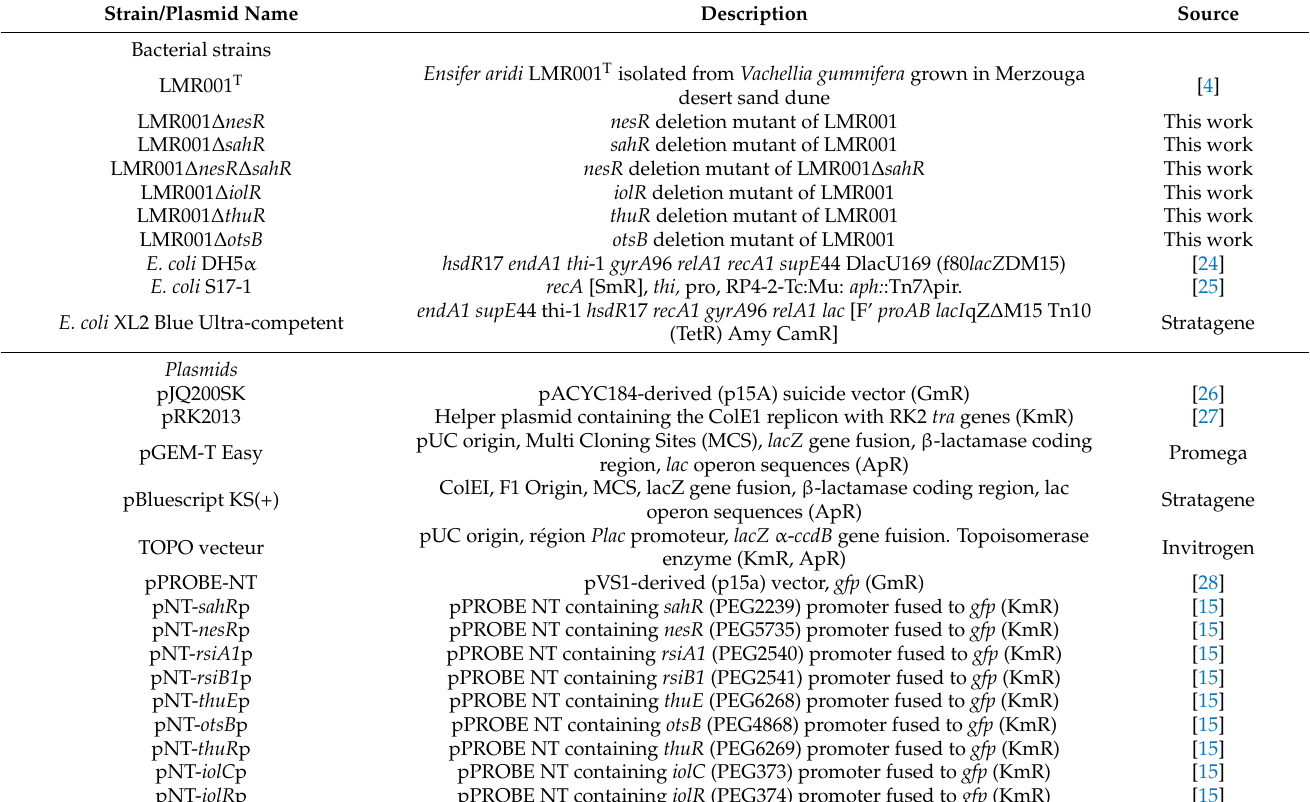
Table 1. List of bacteria and plasmid used in the